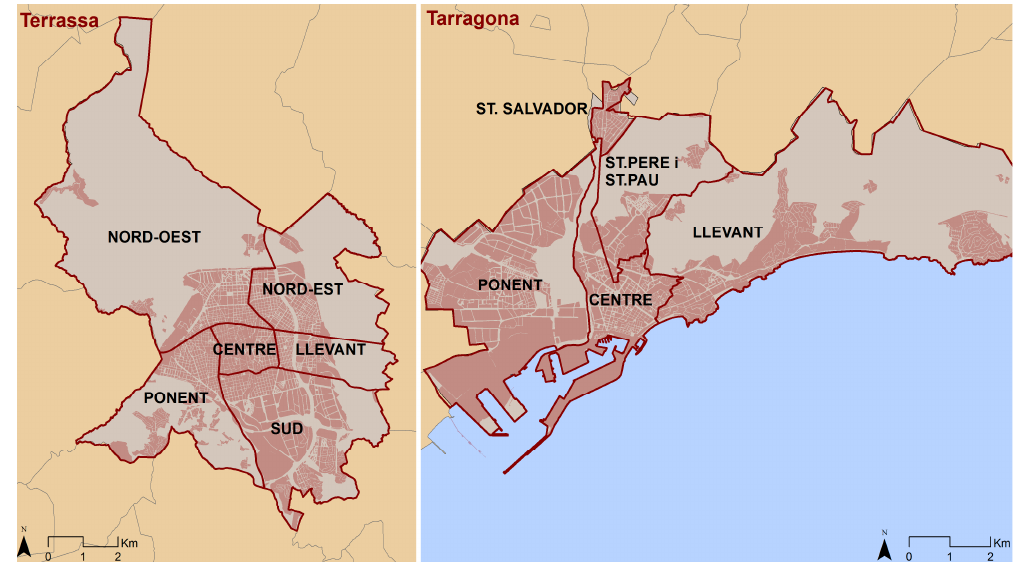
Figure 2. Neighborhood statistical units in Tarragona and Terrassa. Source: own elaboration.